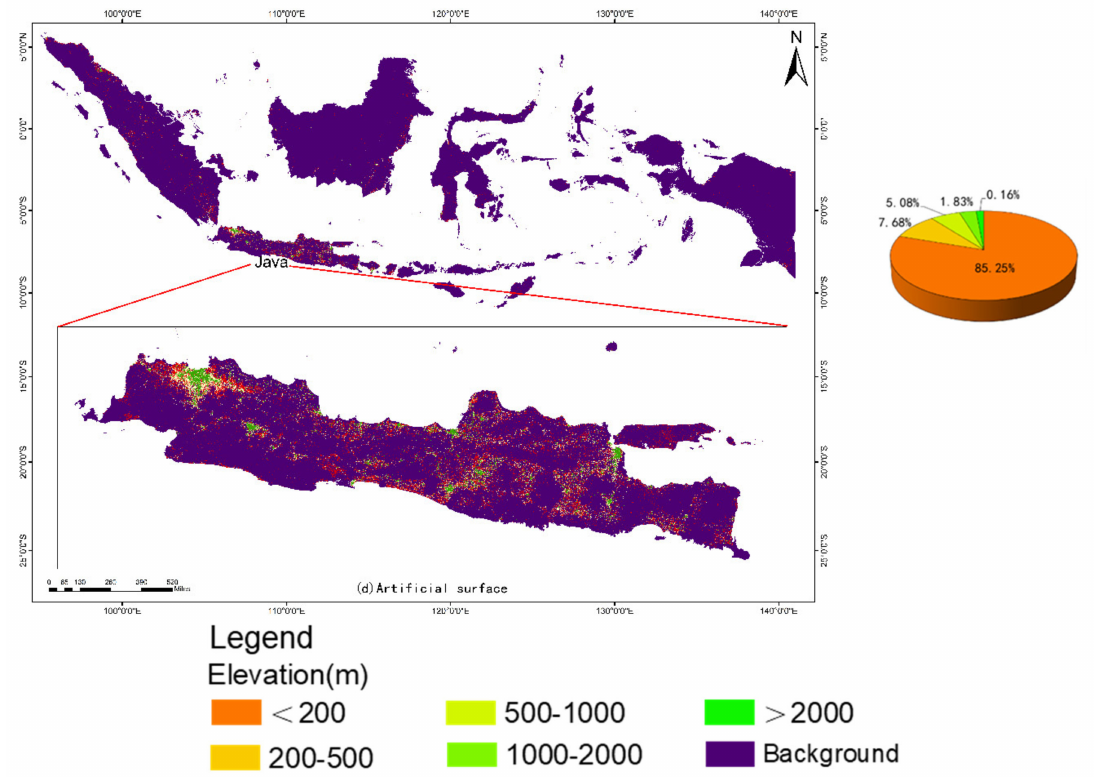
Figure 10. Distributions and area percentage of low-consistency areas of the main land cover types at di ff erent elevations: ( a ) cropland, ( b ) forest, ( c ) grassland, and ( d ) artificial